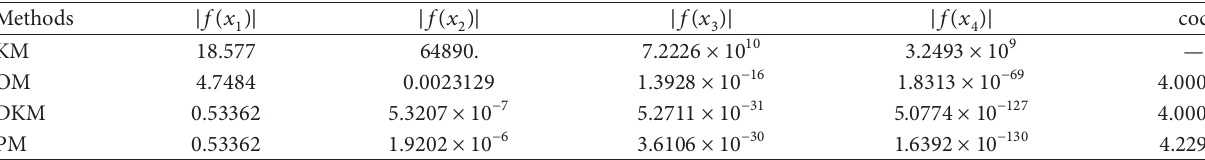
Table 1: Results of comparisons for Example 3 and to find 𝛼 = 2 .